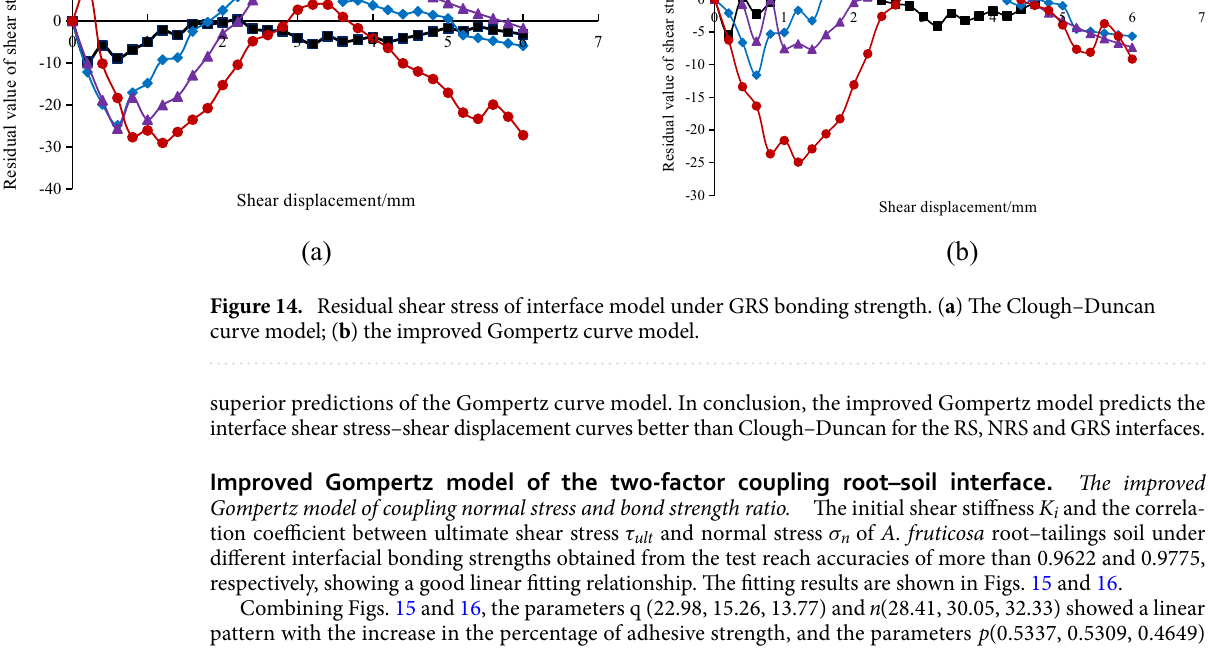
pattern with the increase in the percentage of adhesive strength, and the parameters p (0.5337, 0.5309, 0.4649)